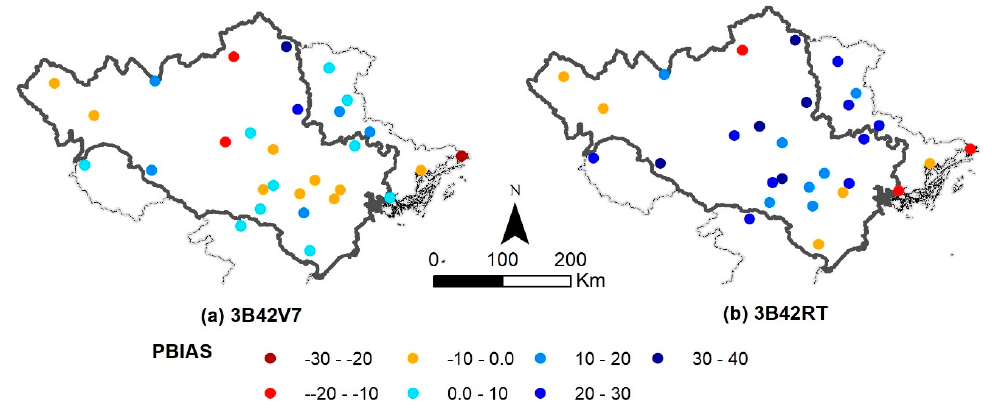
Figure 3. Percentage bias (PBIAS) score’s spatial performance of TMPA products ( a ) 3B42V7 and ( b ) 3B42RT against observation data on both daily and monthly scales from March 2000 to December 2016 over Red–Thai Binh River Basin. The grey line is the Red–Thai Binh River Basin boundary within the Vietnam territory.